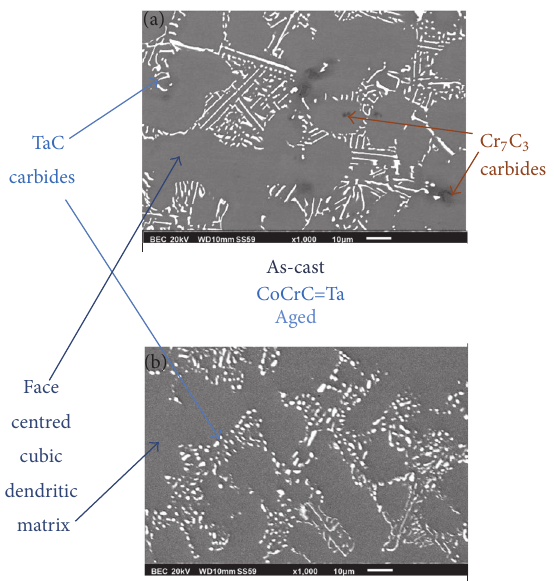
Figure 4: The as-cast (a) and aged (b) microstructure of the “CoCrC=Ta” alloy (SEM/BSE micrographs).